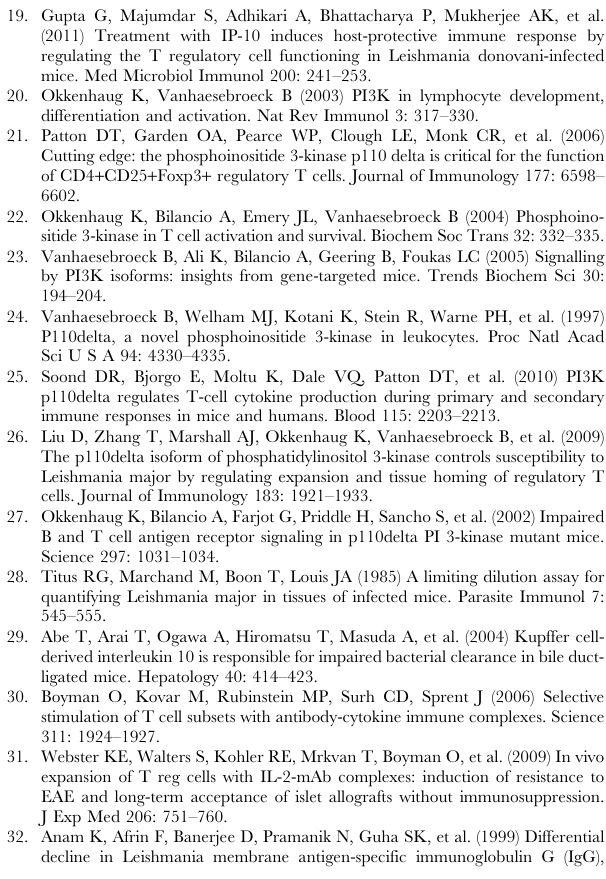
lymphocytes were pulsed with PMA, ionomycin and brefeldin A (BFA) for 4 hrs and directly stained ex vivo for CD3, CD4 and IL-4. Results are representative of 3 independent experiments (n = 3 mice per group) with similar results. Error bars, + / 2 SEM; *, p , 0.05; **, p , 0.01; ***, p , 0.001. (TIF) Figure S5 Enhanced resistance of p110 d D910A mice to L. donovani is not associated with high nitric oxide (NO) production. NO levels were measured in 72 hr culture supernatant fluids of spleen (A) and liver (B) lymphocytes of L. donovani -infected WT and p110 d D910A mice that were stimulated with freeze-thawed L. donovani . Results are representative of 3 independent experiments (n = 3 mice per group) with similar results. Error bars, + / 2 SEM; *, p , 0.05; **, p , 0.01; ***, p , 0.001.